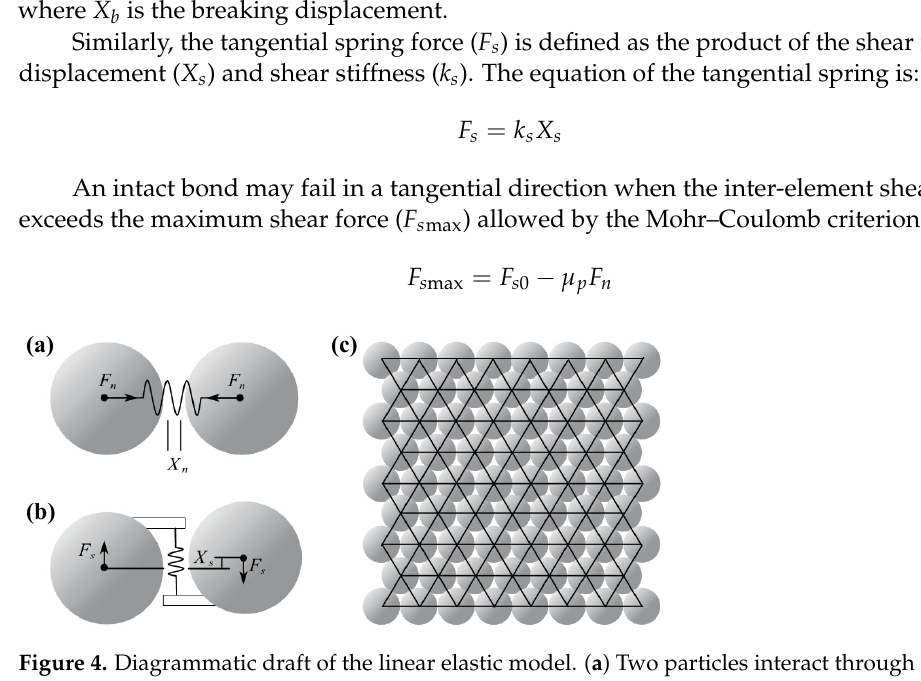
Figure 4. Diagrammatic draft of the linear elastic model. ( a ) Two particles interact through a spring force ( F n ). ( b ) Two particles are also bonded by a spring along the tangential direction to simulate the shear force ( F s ). ( c ) A close-packed discrete element model [36].